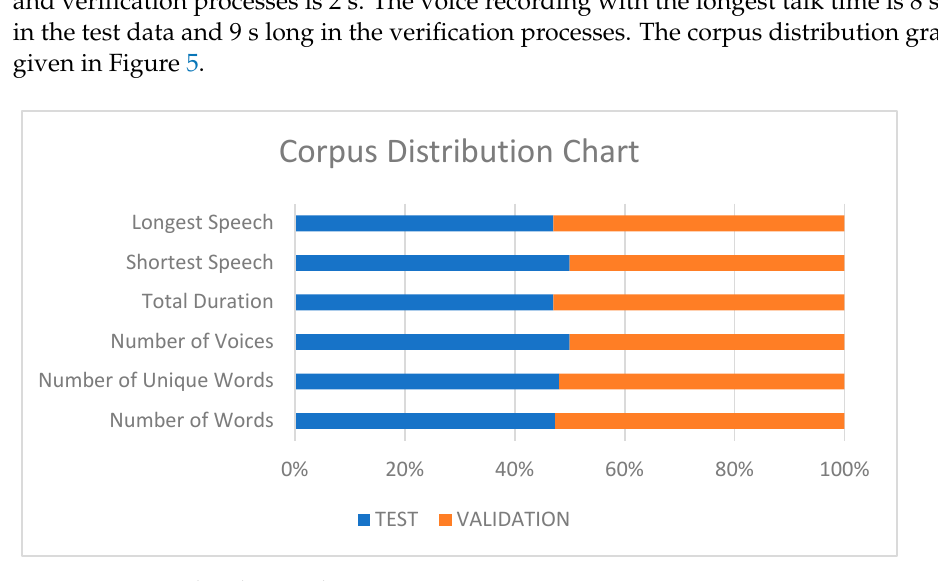
Figure 5. Corpus distribution chart.